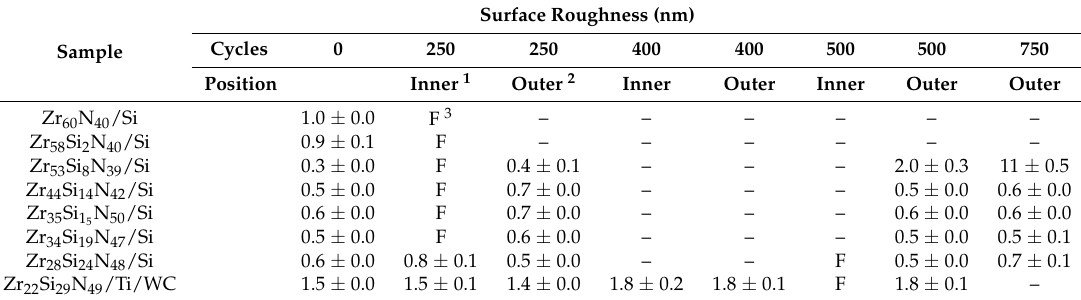
Table 3. Surface roughness variations of Zr–Si–N(0.4,R5) coatings after thermal cycle annealing.